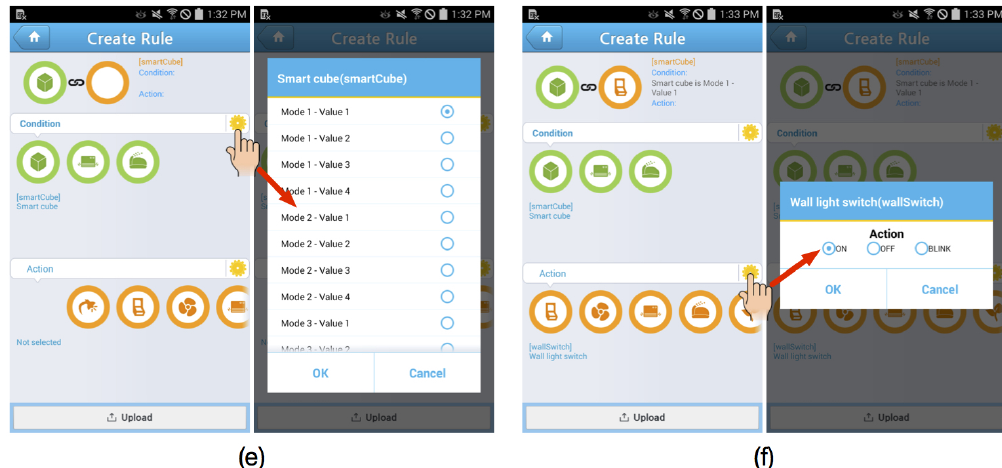
Figure 6. TTEO app examples: ( a ) open and log-in; ( b ) browse rules and configure each rule; ( c ) create a rule between a thermometer and fan-condition setting; ( d ) create a rule between a thermometer and fan-action setting; ( e ) create a rule between smart dice and a wall light switch-condition setting; ( f ) create a rule between a smart dice and wall light switch-action setting.